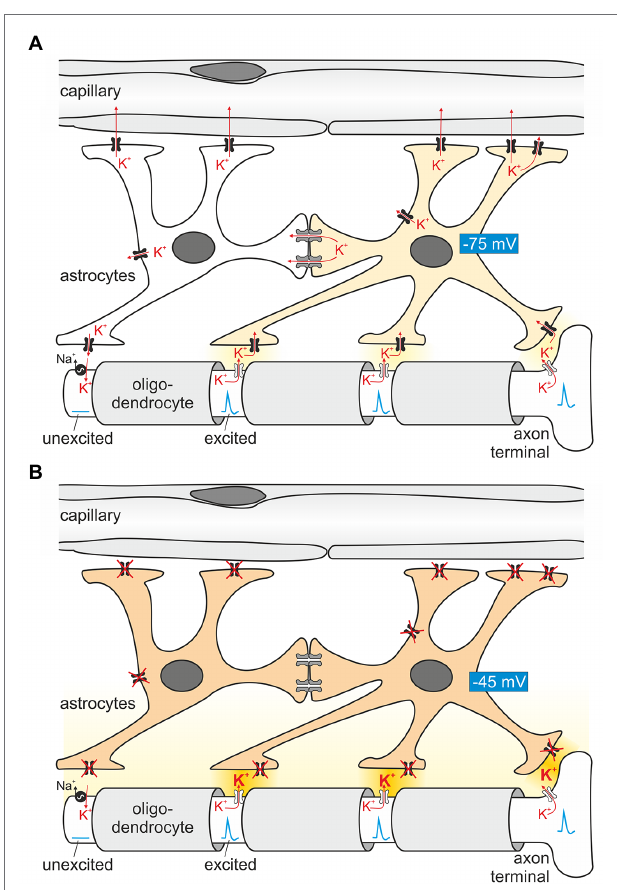
FIGURE 3 | Principles of astroglial K + buffering. (A) Astrocytes are in close contact with Ranvier nodes, exposed parts of the axon between segments wrapped with myelin (light gray) provided by oligodendrocytes. The nodes “regenerate” the action potential as it travels in a saltatory (jumping) mode to the next node. Conduction between nodes is electrotonic. When firing, Na + enters the axon, depolarizes the nodal axolemma and K + is leaving the axon through K + channels (Kanda et al., 2019). The ensuing K + exit from the axon increases extracellular K + locally and induces K + uptake by astrocyte processes in close proximity. A prerequisite of locally restricted K + uptake by astrocytes is their hyperpolarized membrane voltage (requiring Kir4.1 channels depicted in black). On the other hand, K + uptake depolarizes the astrocyte membrane and enhances the driving force for K + exit at areas closer to blood vessels, where the K + concentration is low. In addition, K + is also transferred by electrical coupling to neighboring astrocytes which are, at this moment in time, not surrounded by increased K + . Once the nodal axon repolarizes, the axolemmal Na + /K + -ATPase takes up K + released slowly by the astrocyte. (B) When astrocytes lack functional Kir4.1 channels, extracellular K + is expected to rise (darker yellow extracellular space), and spontaneous action potential generation ensues, explaining the epilepsy seen in EAST